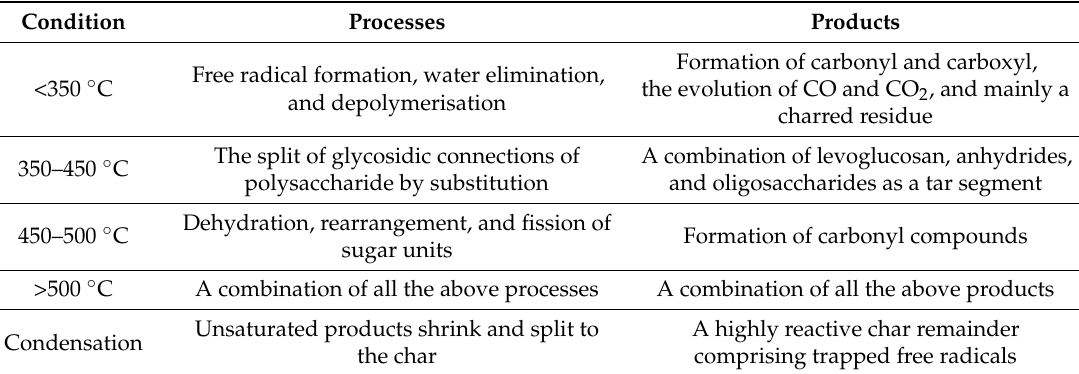
Table 4. Pyrolysis processes at different